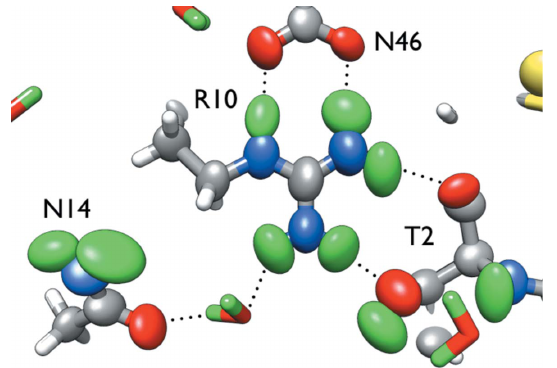
Figure 16 Top, X-ray electron-density map at 0.83 A˚ resolution showing ambiguous hydrogen-bonding networks in water molecules associated with crambin. Bottom, nuclear density map at 1.1 A˚ showing the hydrogen-bonding network and clear density for water molecules. Reprinted with permission from Chen et al. (2012), Proc. Natl Acad. Sci. USA , 109 , 15301–15306. Copyright (2012) National Academy of Chen & Unkefer (cid:4) Fifteen years of the Protein Crystallography Station